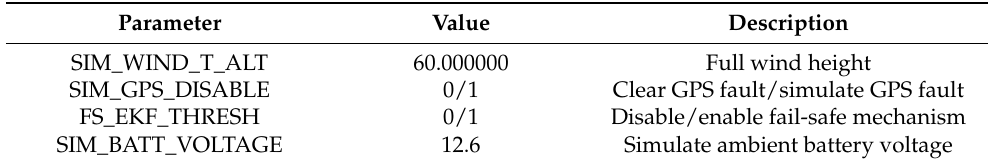
Table 1. Some parameter settings in the GPS failure simulation.